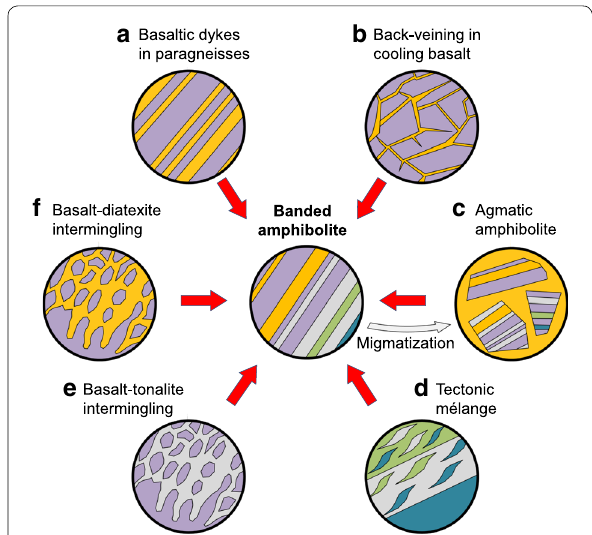
Fig. 12 Scheme of possible protoliths ( a – f ), which are metamorphosed and deformed (red arrows) to result in